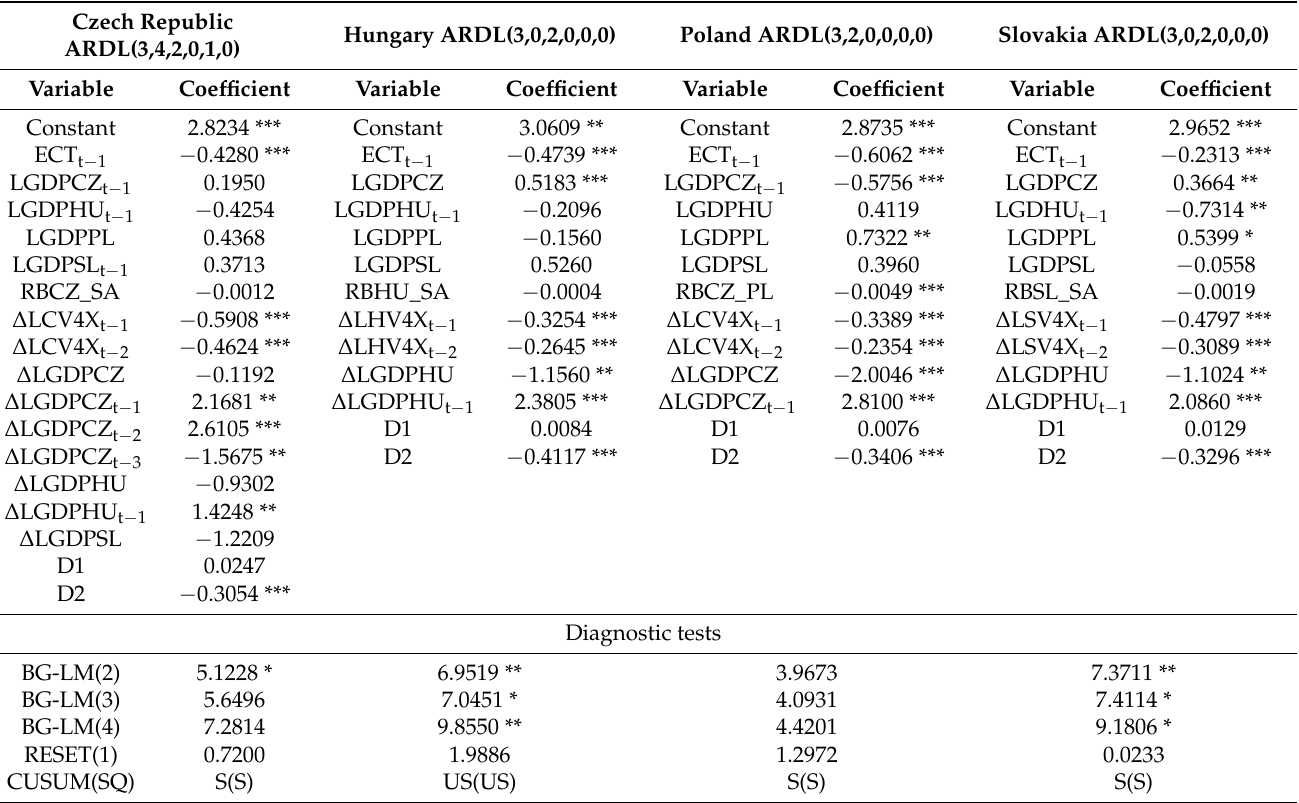
Table 6. ARDL model results for